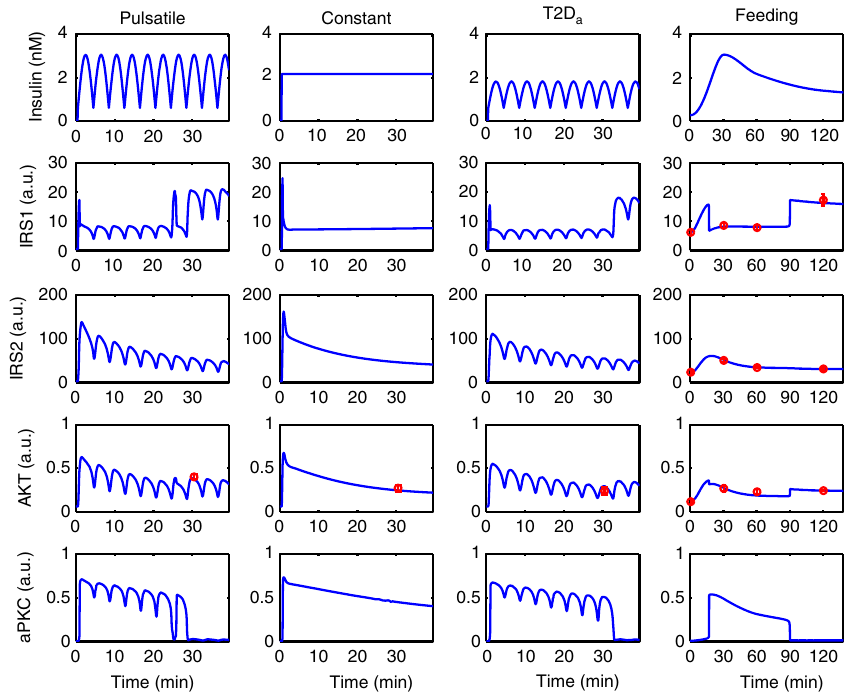
Fig. 2 Best fi tting result of the minimal model (M4 in Table 1; solid arrows in Fig. 1). The activities of the signaling molecules are plotted with arbitrary unit (a.u.). Each column corresponds to one speci fi c experiment. Experimental data are indicated by red circles with error bars (s.e.m). See Supplementary Fig. 2 for similar results based on other parameter sets